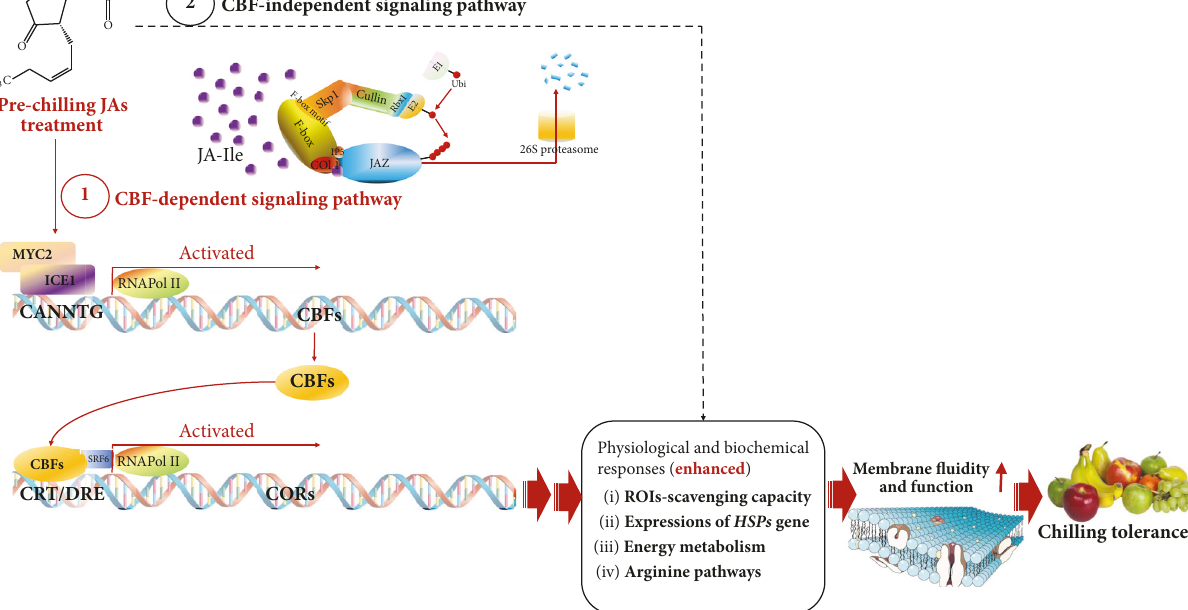
Figure 6: Prechilling jasmonates (JAs) treatment activates CBF-dependent signaling pathway and thus induce physiological and biochemical responses to enhance the chilling tolerance of postharvest horticultural commodities [9, 78,